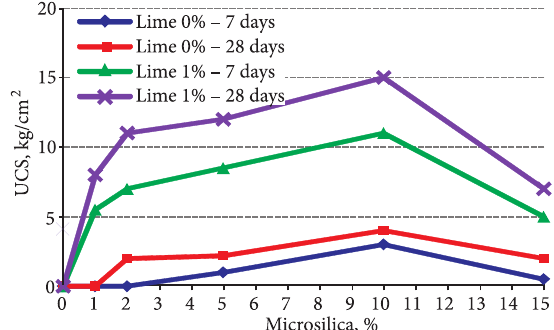
Fig. 12. Changes in unconfined compressive strength of wet samples containing 0 and 1 % of lime with different percentages of Microsilica